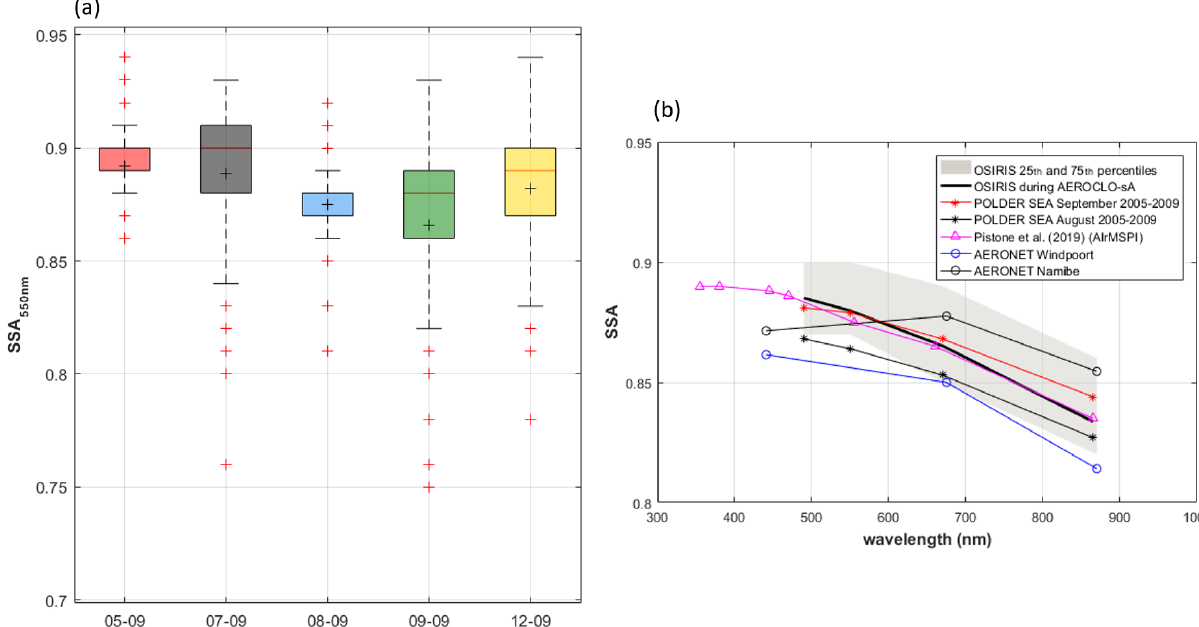
Figure 9. Box plot of the SSA from OSIRIS measurements at 550nm for the five selected flights and mean wavelength dependency retrieved from OSIRIS, Windpoort, and Namibe AERONET sites during the AEROCLO-sA campaign and AirMSPI during the ORACLES campaign in 2016 and POLDER between 2005 and 2009 during the fire season.